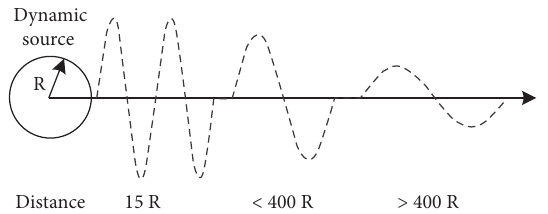
Figure 3: Dynamic load propagation